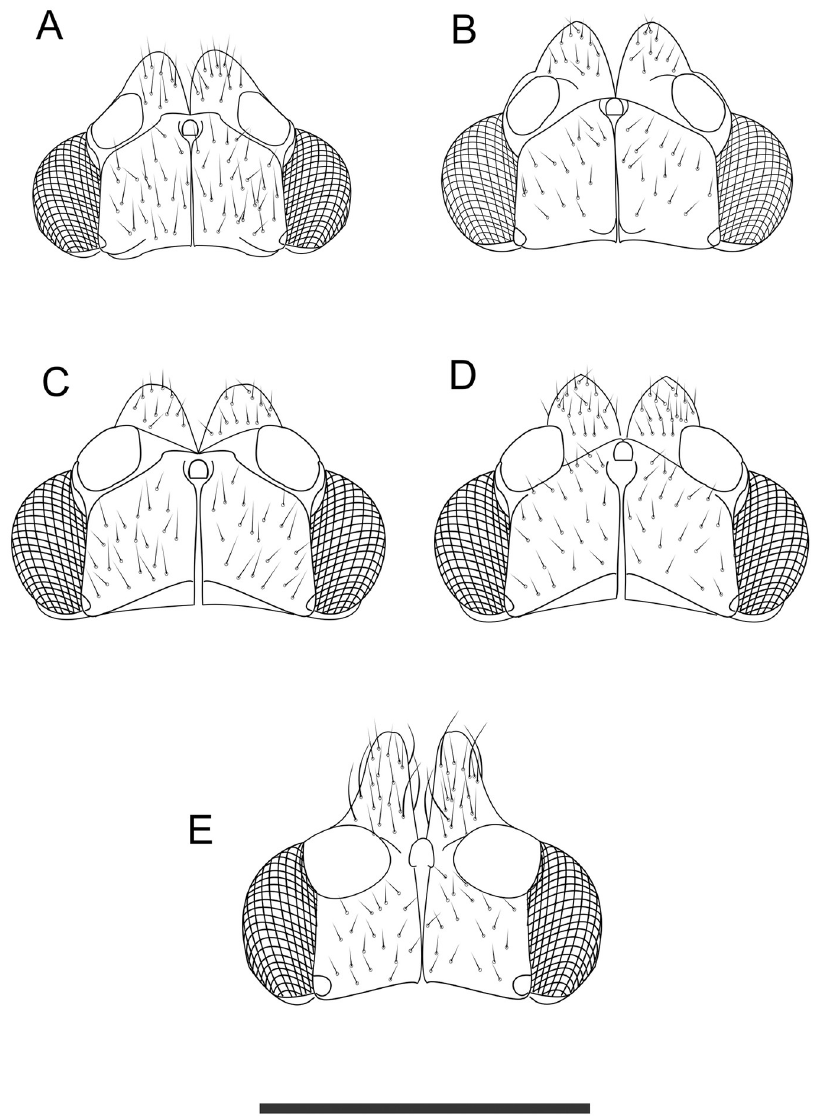
Fig 7. Dorsal view of head of Trioza melaleucae ( A ), T . curta ( B ), T . adventicia ( C ), T . eugeniae ( D ) and T . erytreae ( E ). Scale bar is 0.2 mm. 3.1.4. Colouration. 3 . 1 . 4 . 1 . Adult . Overall colour of the body consistently different between males and females. Females spanning from a light-brown orange to brown (Figs 1B and 1D and 2A and 2C), males are darker, from dark-brown/dark orange to black (Figs 1A and 1C and 2B and 2D). Independently from this sexual dimorphism, the legs of both sexes tend to a lighter colouration (yellowish) from the tibia down to the claws, while the femur remains of the same colouration as the body. Additionally, both the first and the last segment of the abdomen are white, both in males and females (Figs 1A–1D and 2A–2D). Eyes dark red to burgundy. Genal processes have the same colour as the head, brown for females and dark brown to black for males. Antennae with segments 1 and 3 light orange, 2 and 4 orange at base progressing to dark brown to black terminally; segments 5–8 dark brown to black,